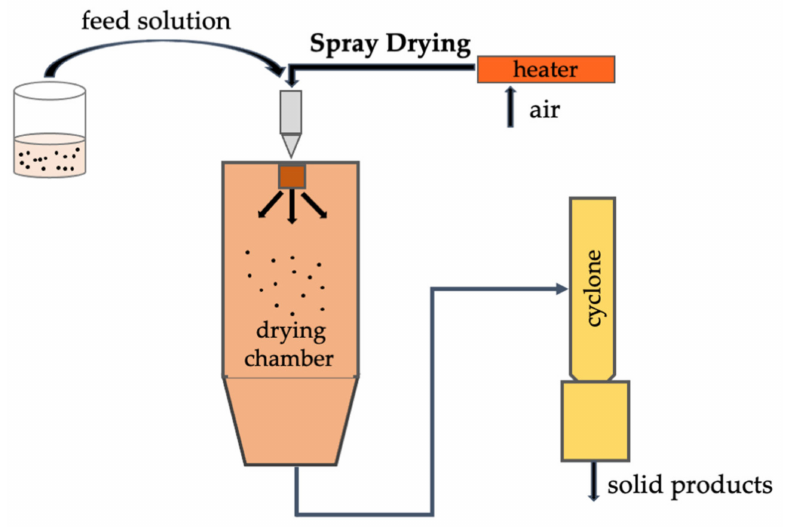
Figure 3. Schematic illustration of spray-drying